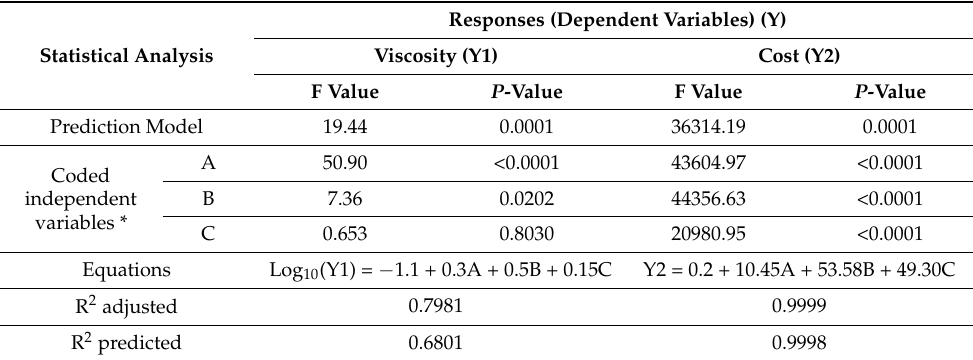
Table 4. Statistical analysis of the estimated effect of the independent variables on the viscosity and cost of formulations obtained using phospholipids extracted from sunflower (H100 and H20) and soybean (S75) as emulsifiers for sunflower and rosehip oils.